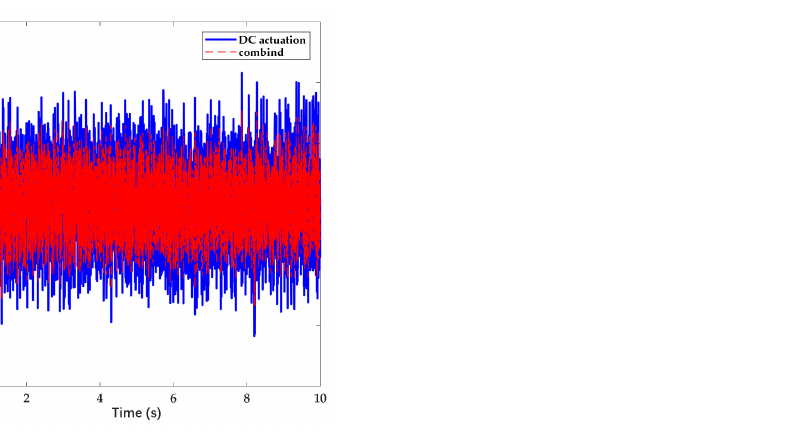
Figure 10. Acceleration error while applying DC actuation and combined actuation. The coefficient n increases with time.